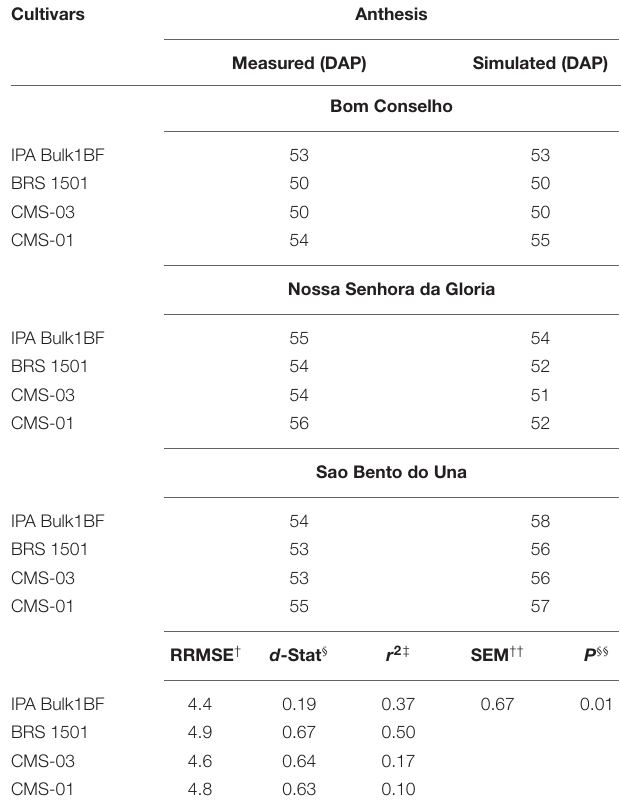
TABLE 3 | Forage accumulation for pearl millet under rainfed conditions at three locations in Brazil, as measured and simulated after calibration. Cultivars